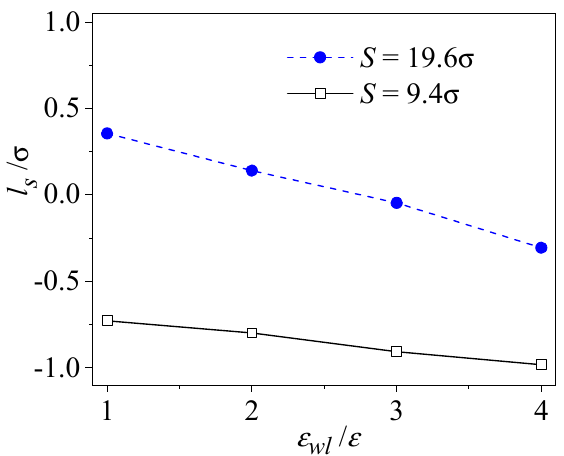
Figure 7. The effect of wall-fluid coupling strength on slip length ( ρ w = 2 ρ , δ = 1.57 σ ).